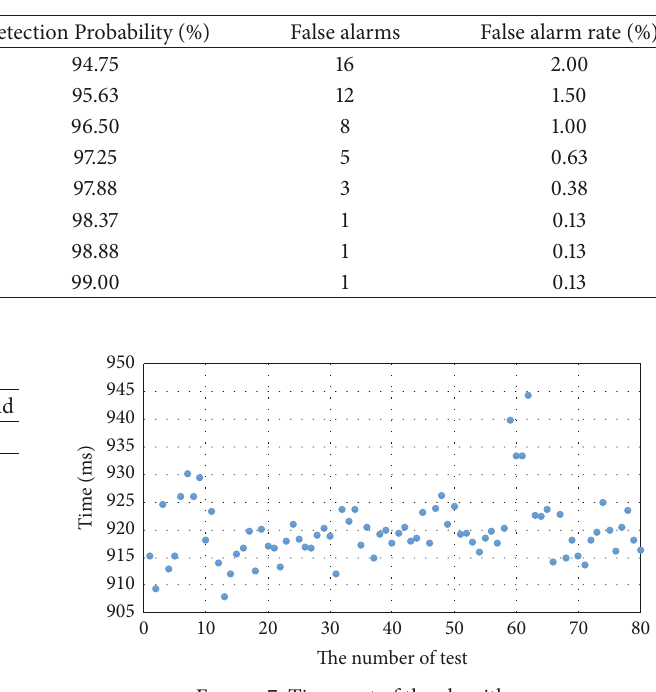
Figure 7: Time cost of the